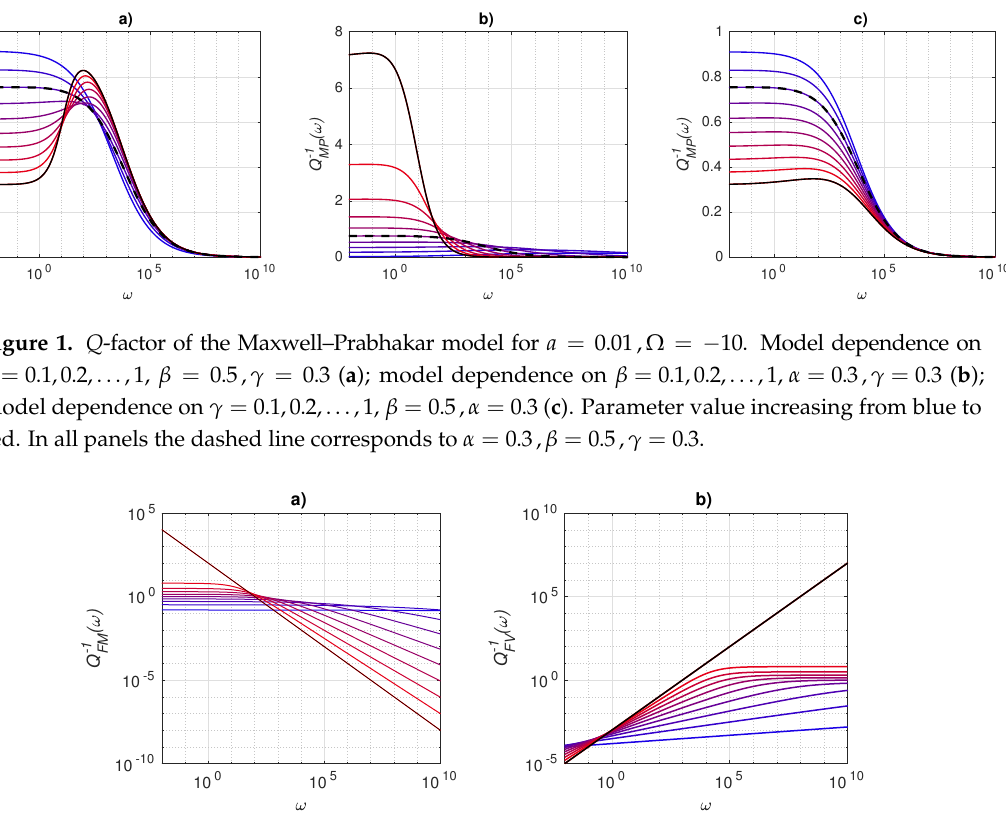
Figure 2. Q -factor of fractional Maxwell model with a = 0.1 ( a ), fractional Voigt model with M = 10 3 , B = 1 ( b ). Parameter value increasing from blue to red.